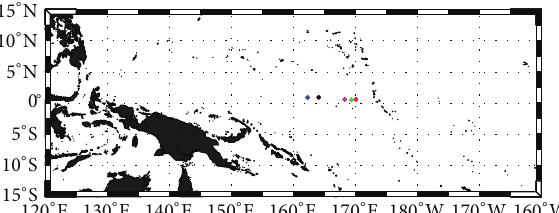
Figure 7: The average location of the centroid of WPWP in different events.ElNi˜no(Red),ElNi˜noModokiI(Magenta),ElNi˜noModoki II (Green), La Ni˜na (Blue), and the normal (Black), respectively.